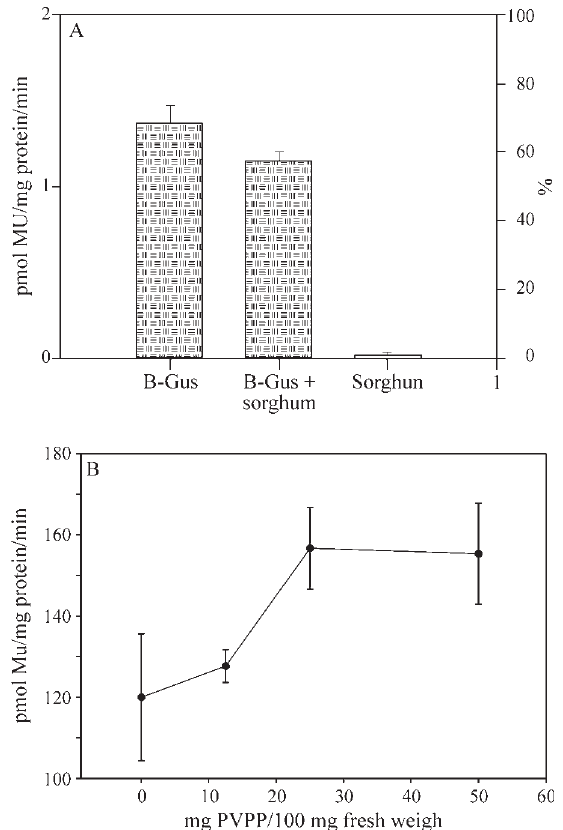
Figure 4 - A: Effect of sorghum leaf extracts of a non-transformed plant on E. coli β -glucuronidase activity when both are mixed together during homogenization. Mean ± SE for six samples. B: Effect of PVPP concen- trationonGUSactivityintransgenicsorghumleaves.Mean ± SEforthree samples.